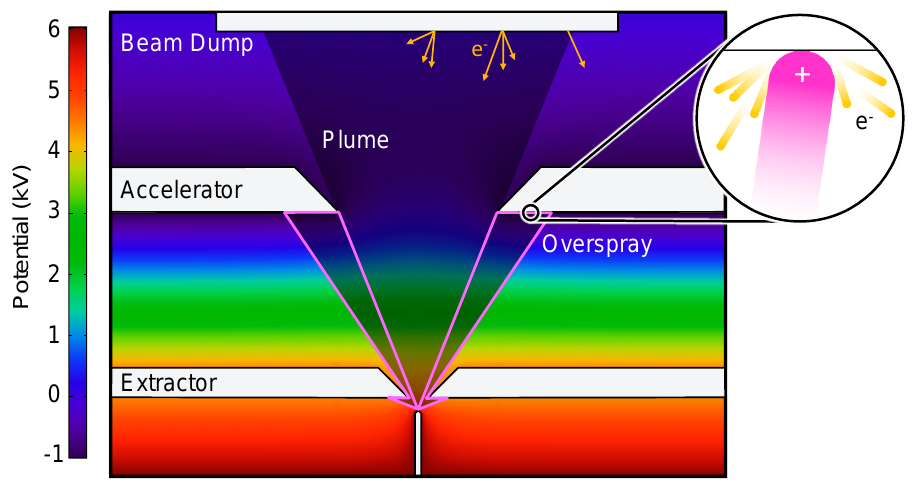
Figure 1. Electrospray thruster schematic with extraction and acceleration potentials shown (modified from [7]). Charged droplets and ions impinging the electrodes and beam dump, as shown, can cause ion-induced electron emission (IIEE), increased measurement uncertainty, and possible electron back